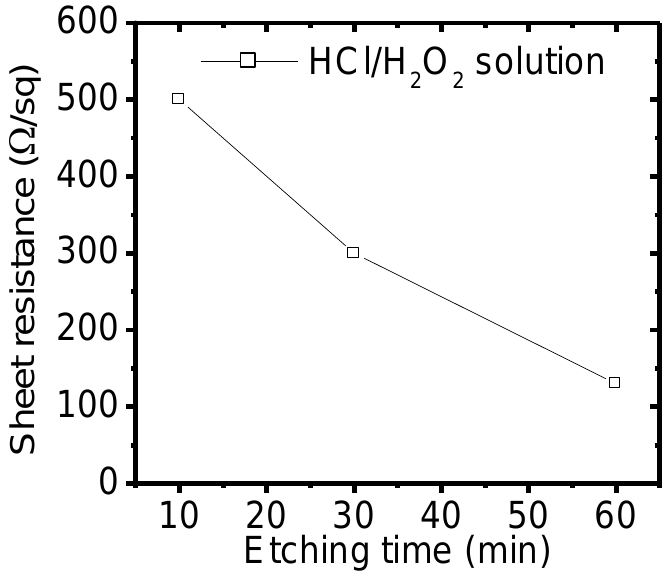
Figure 6. Sheet resistances of the SPTB layer/p-type Si(100) substrates etched in mixed HCl/H O solution at 10, 30, and 60 min, 2 2